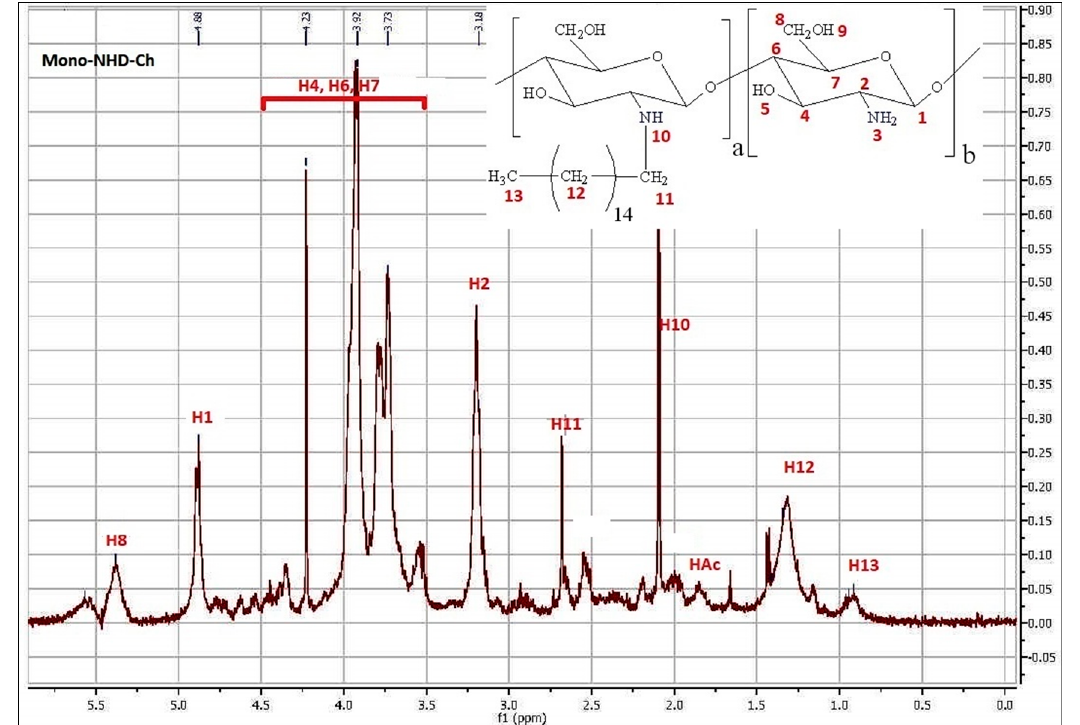
Figure 3. H NMR analysis of chitosan and its alkyl derivatives (Mono-NHD-Ch and Di-NHD-Ch). Table 2. Inhibition indices of chitosan and chitosan alkyl derivatives against E. coli , P. aeruginosa , S. aureus , and B. cereus . Values are expressed as mean ± SD (n =